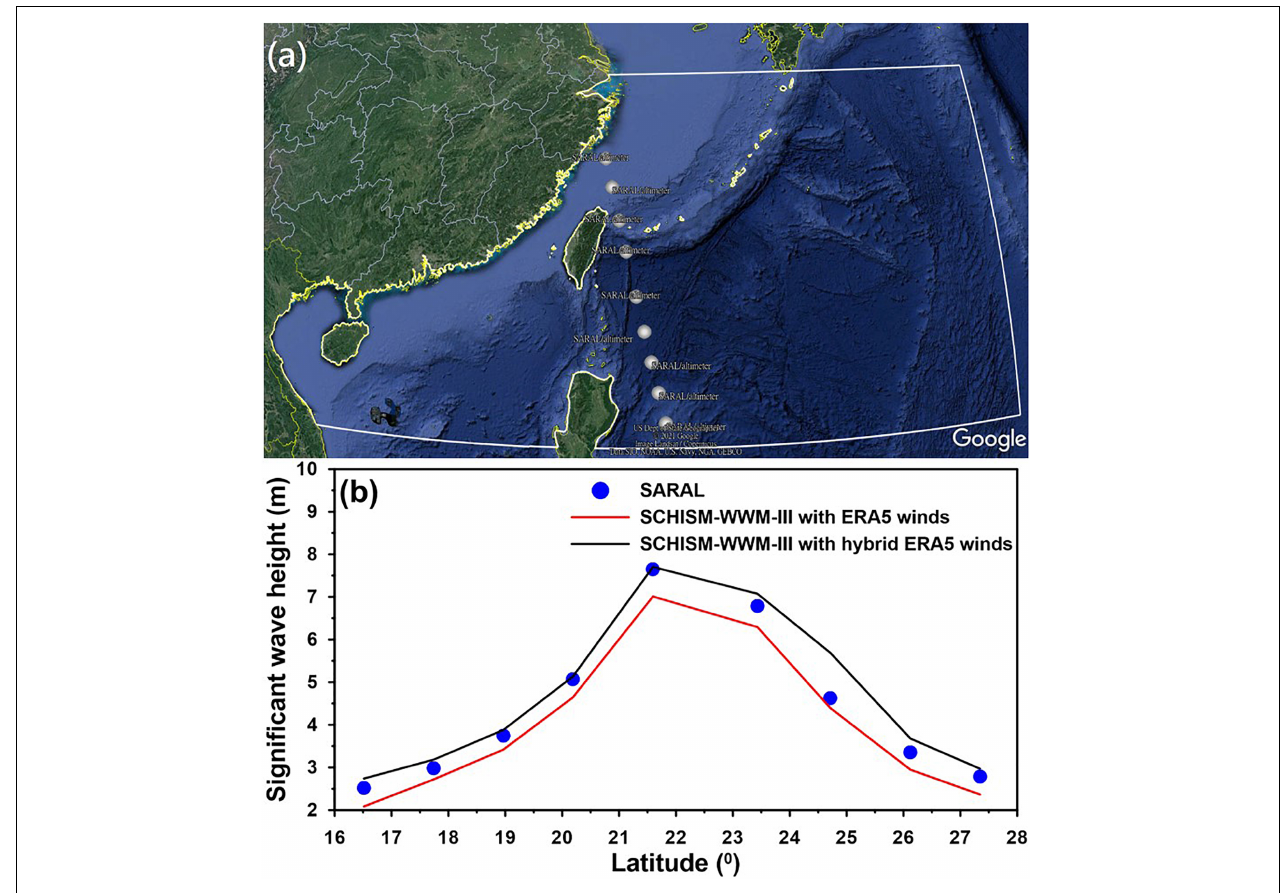
FIGURE 3 | (a) Satellite with ARgos and ALtiKa (SARAL) orbit in the computational domain at UTC 21:30 on Sep. 13, 2016, and (b) along-track significant wave heights measured by altimeter on SARAL with hindcasted significant wave heights derived from the original ERA5 and modified ERA5 wind fields for Super Typhoon Meranti in